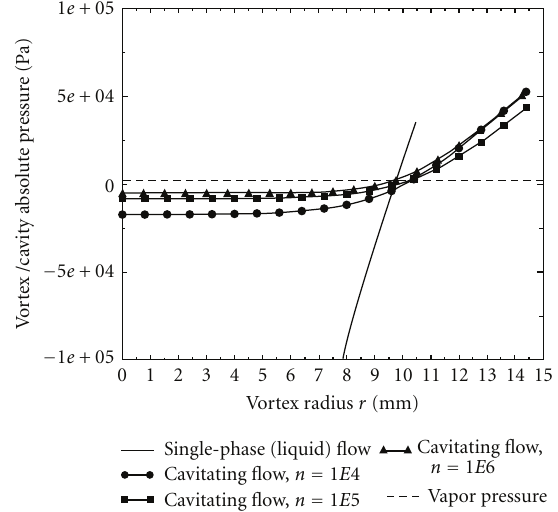
Figure 10: Influence of the bubble density number n on the pressure distribution inside the cavity.